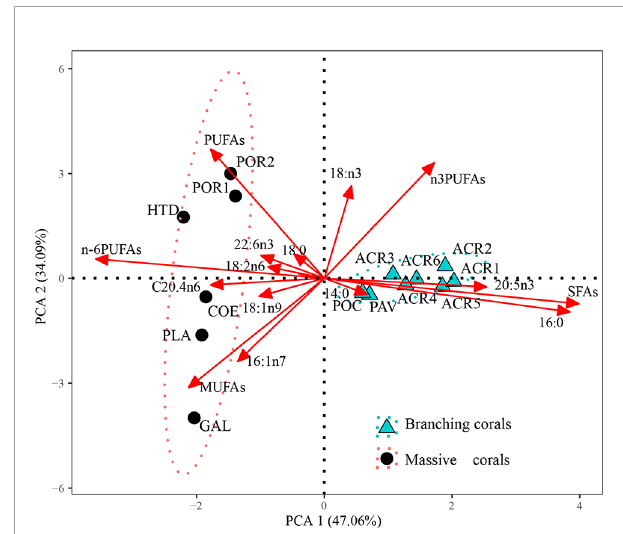
FIGURE 3 | Principal component analysis (PCA) of fatty acids (% of total fatty acids) of massive (black round) and branching (green triangle) corals (only healthy